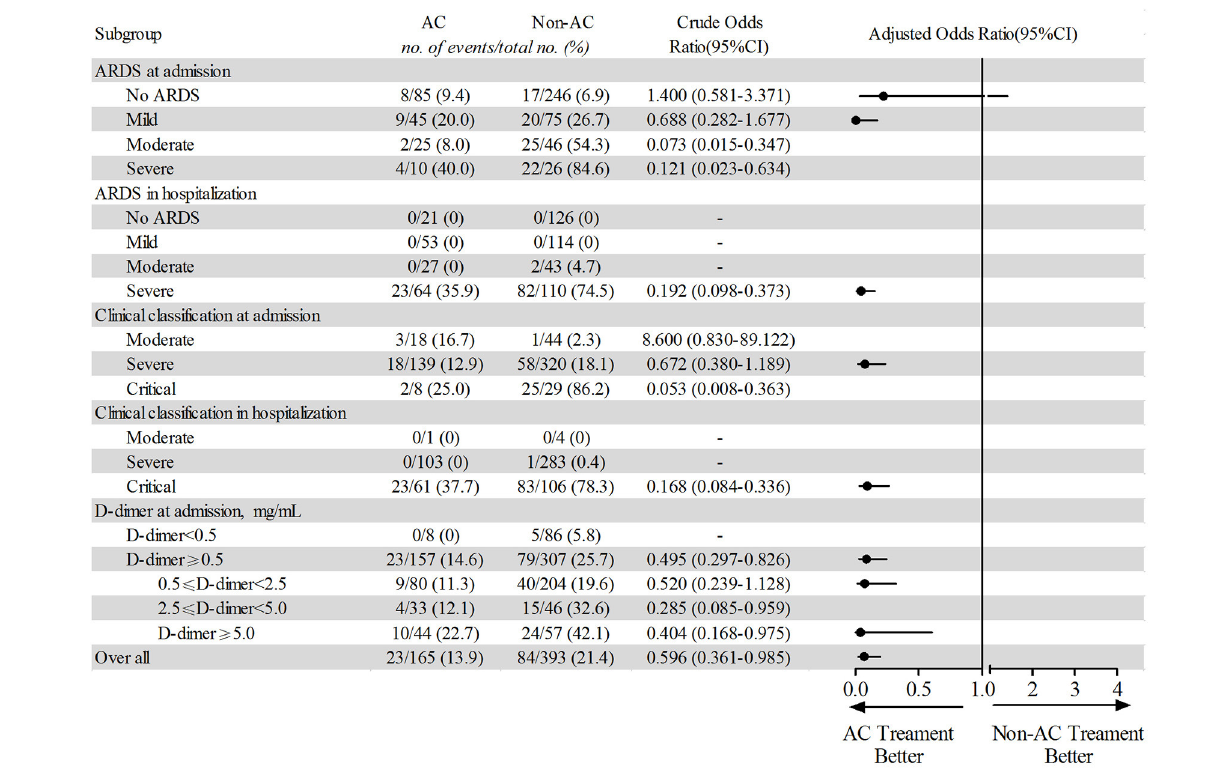
FIGURE 3 | Subgroup analysis based on clinical stratification of in-hospital mortality between AC treatment and non-AC treatment patients. The multivariate logistic regression analysis adjusted for baseline covariates including age, smoking, comorbidities, white blood cells, D-dimer, lactate dehydrogenase, urea, antiviral therapy,